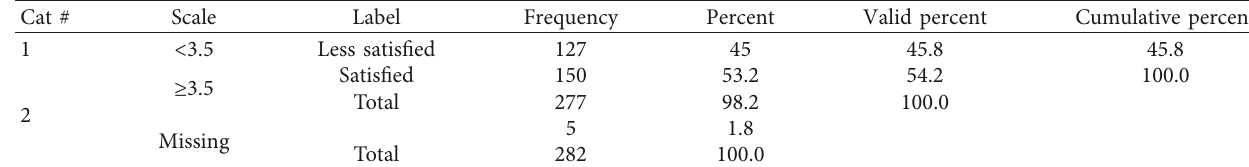
Table 8: Overall student satisfaction classification.